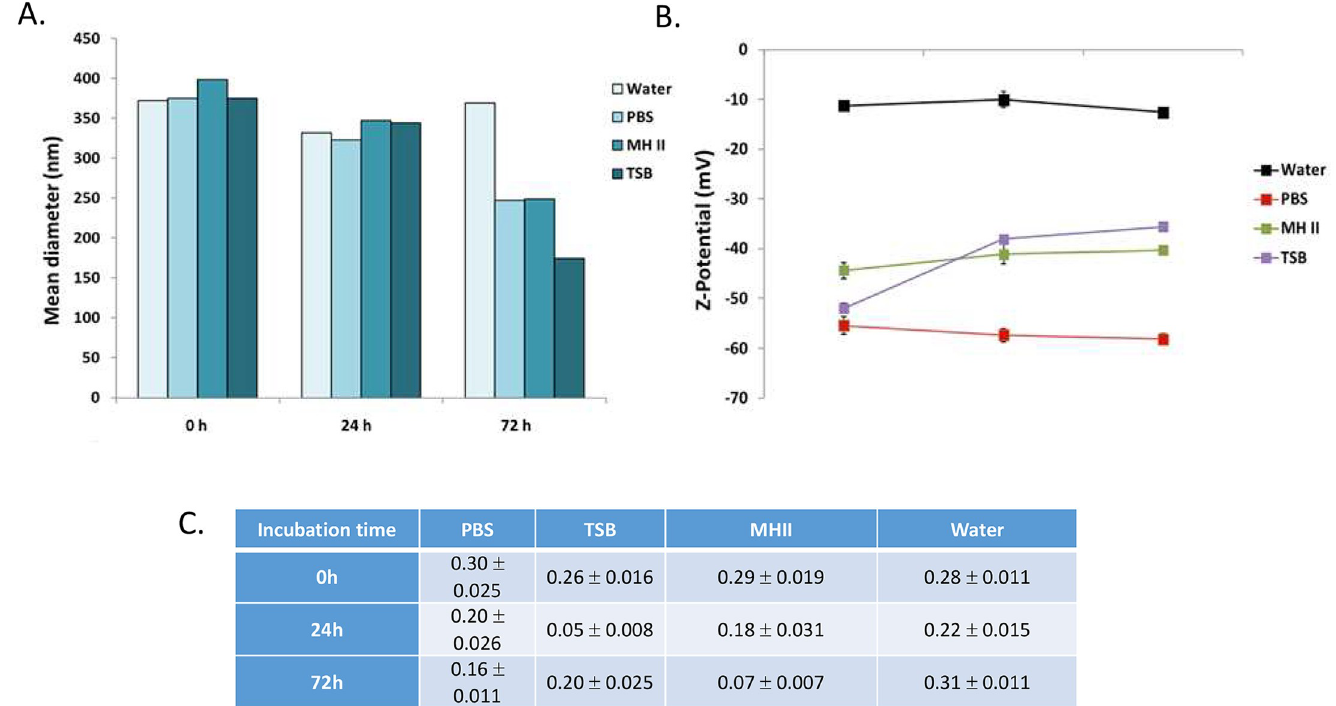
Fig 5. Stability analysis of TFD-CS-NC nanocarriers over a 72-hour timeframe in a variety of storage and biological buffers. A) Size analysis B) zeta potential analysis and C) polydispersity index.